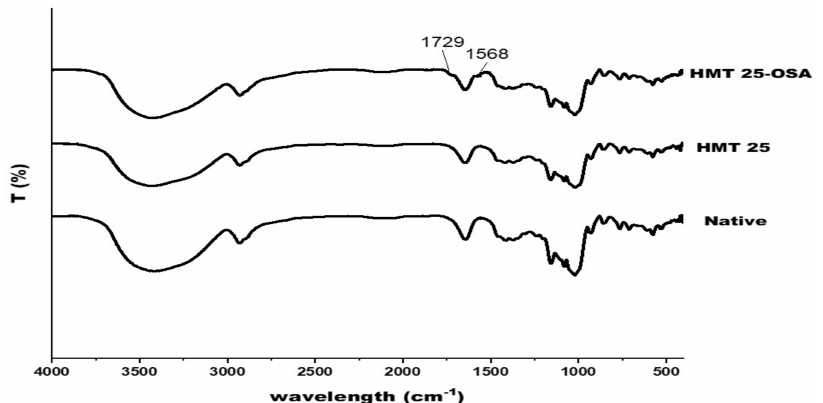
Figure 7. Fourier transform infrared (FTIR) spectrum (wavenumber range 400 and 4000 cm − 1 ) of native, HMT, and modified HMT—octenyl succinic anhydride of sago starch. Native: native sago starch; N-OSA: native sago starch—OSA modification; HMT25: HMT sago starch treated 25% moisture treatment; H25-OSA: HMT 25—OSA modification.